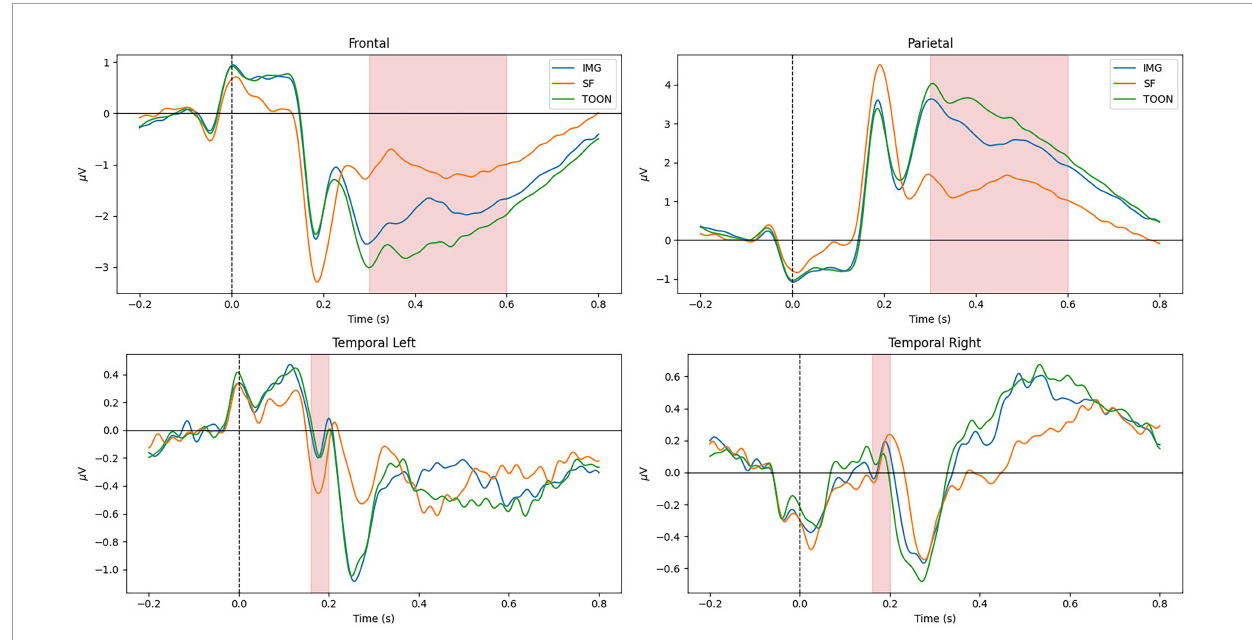
FIGURE4 Grand average ERP on frontal, parietal, temporal left, and temporal right regions of interest aggregated by experimental categories: control (IMG), scrambled (SF), and cartoonish (TOON) faces.